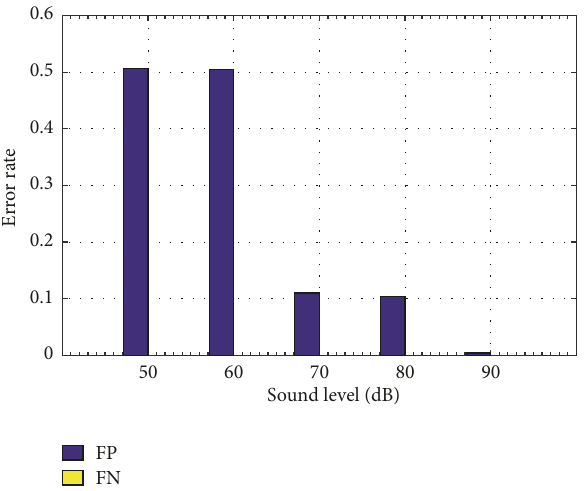
Figure 6: FN and FP rate in different sound levels.